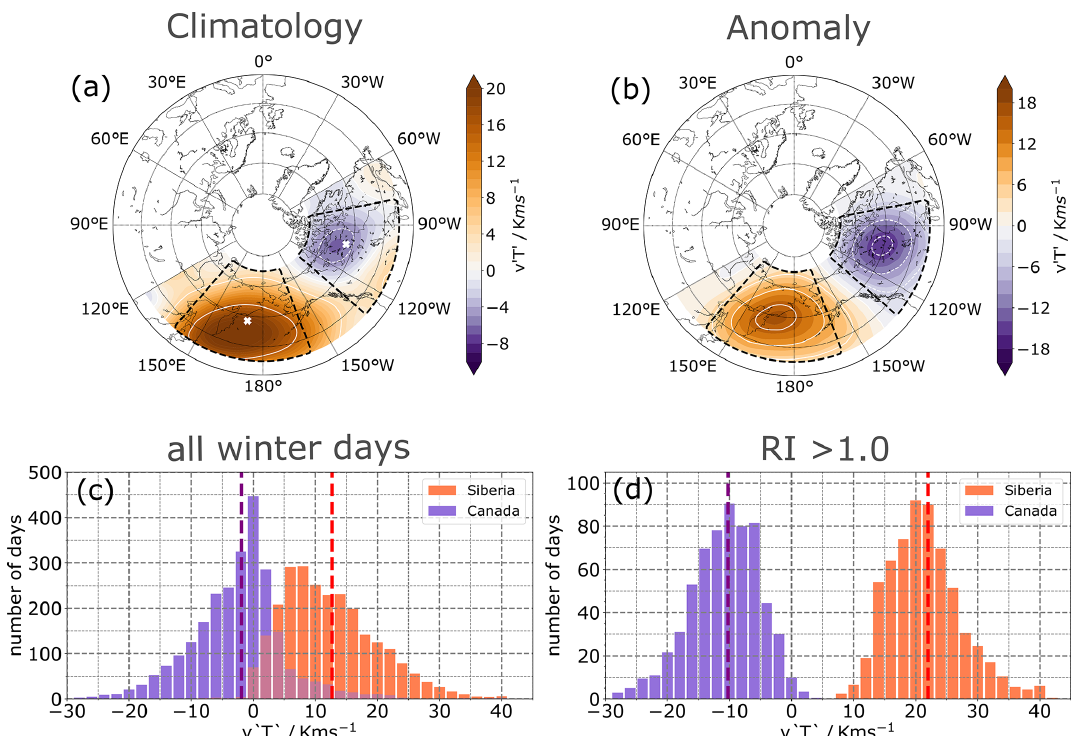
Figure 1. (a) Climatology of the wintertime local daily meridional heat flux v (cid:48) T (cid:48) at 100hPa in the Siberian and Canadian sectors. The white crosses mark the average centres of mass of the meridional heat flux in the Siberian and Canadian sectors during reflection events. (b) Composite anomaly of the local daily meridional heat flux at 100hPa during reflection events. Histograms of daily meridional heat flux v (cid:48) T (cid:48) at 100hPa averaged for the Canadian (blue) and Siberian (red) sectors for (c) all winter days and (d) only for days when RI > 1.0. The vertical dashed lines represent the averages over all days. The data cover the DJFM seasons from 1979/1980 to